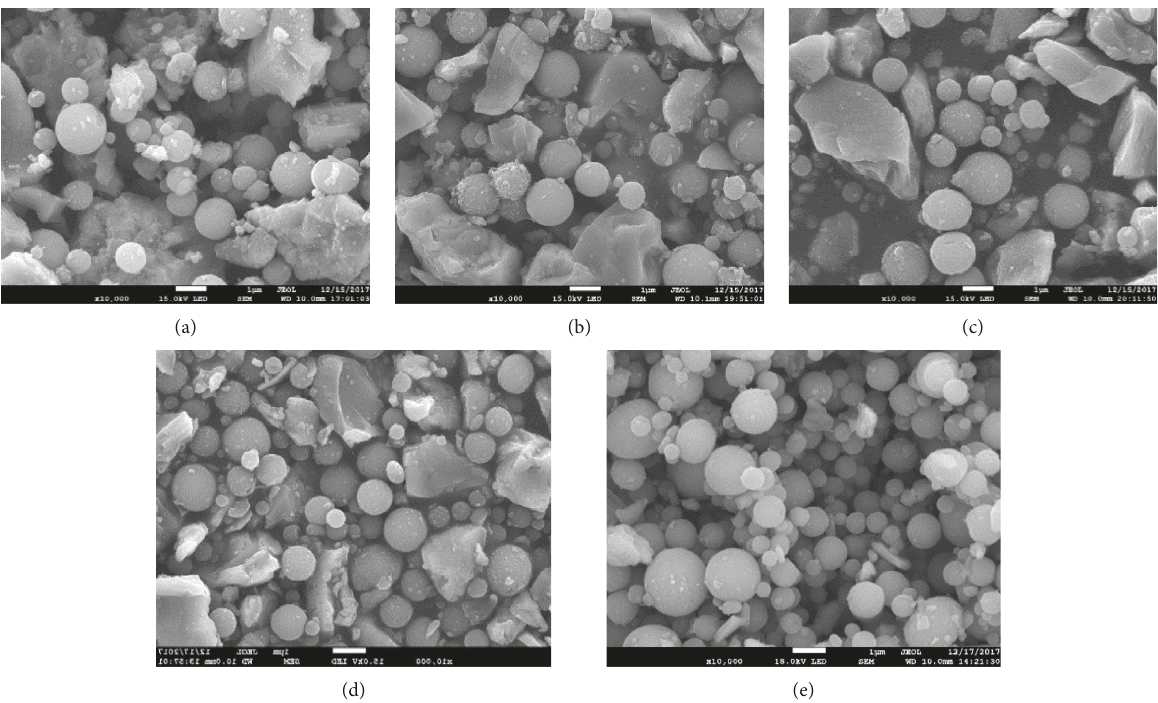
Figure 6: FE-SEM images of different samples. (a) 1#. (b) 2#. (c) 3#. (d) 4#. (e)